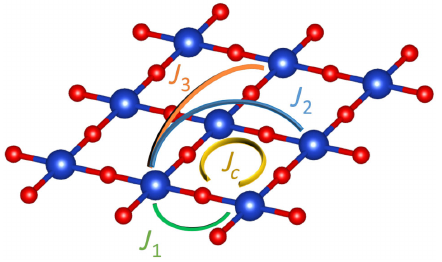
FIG. 1. Scheme of CuO 2 planes, with oxygen atoms depicted in red and copper atoms in blue. Colored lines highlight the magnetic coupling of the Hubbard-like Hamiltonian as explained in the